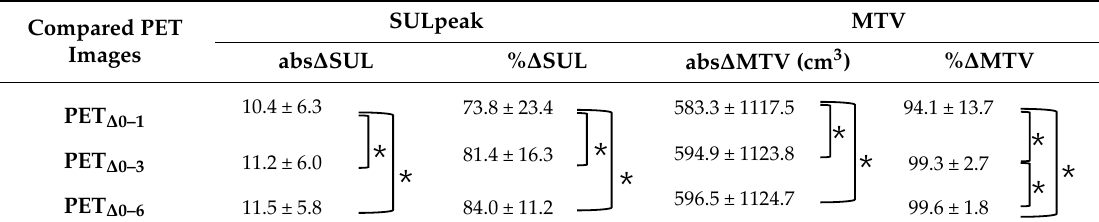
Table 3. Changes of SULpeak and MTV compared to baseline PET/CT.